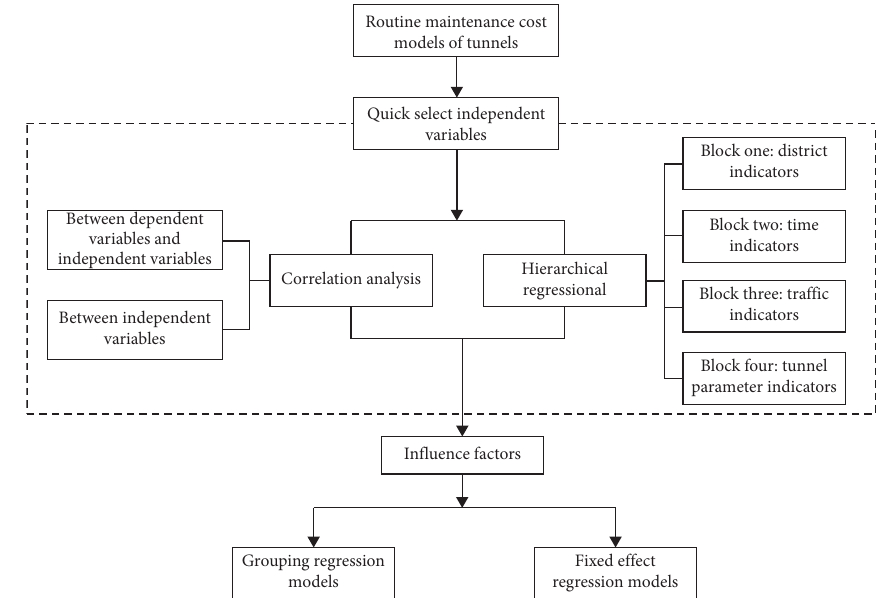
Figure 2: Flow chart of the TMC